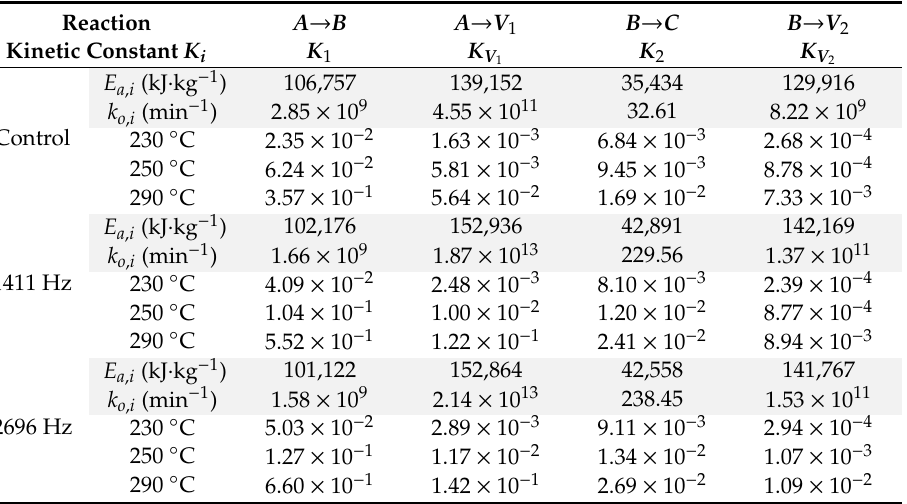
Table 3. The obtained kinetic parameters under control and thermoacoustic torrefaction experiments (1411 and 2696 Hz) for 230, 250, and 290 ◦